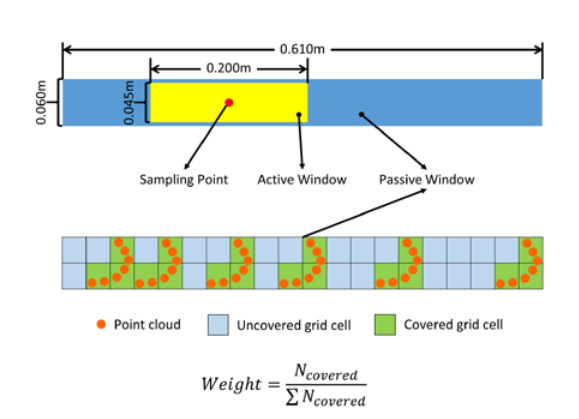
Figure 6. Schemetic illustration of the footprint of the retroreflectometer and the weighting scheme taking the passive window as an